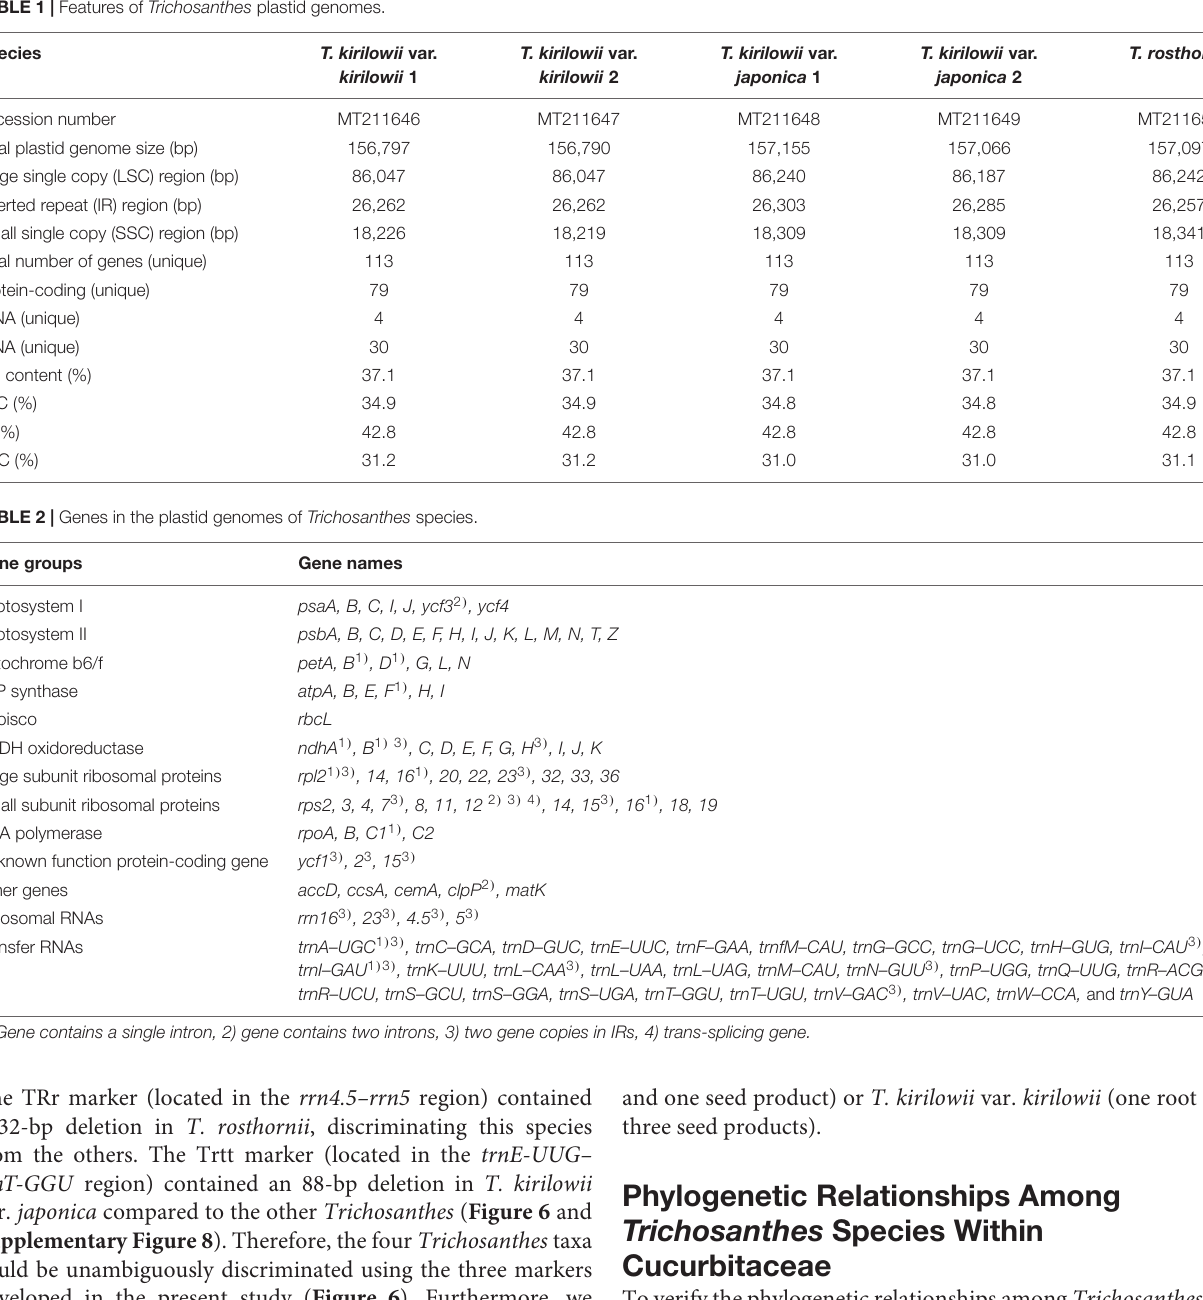
Figure 9 ). Phylogenetic relationships inferred from BI and Figure 9 ). All phylogenetic relationships were strongly supported (BI PP = 1.0). Trichosanthes formed a monophyletic group